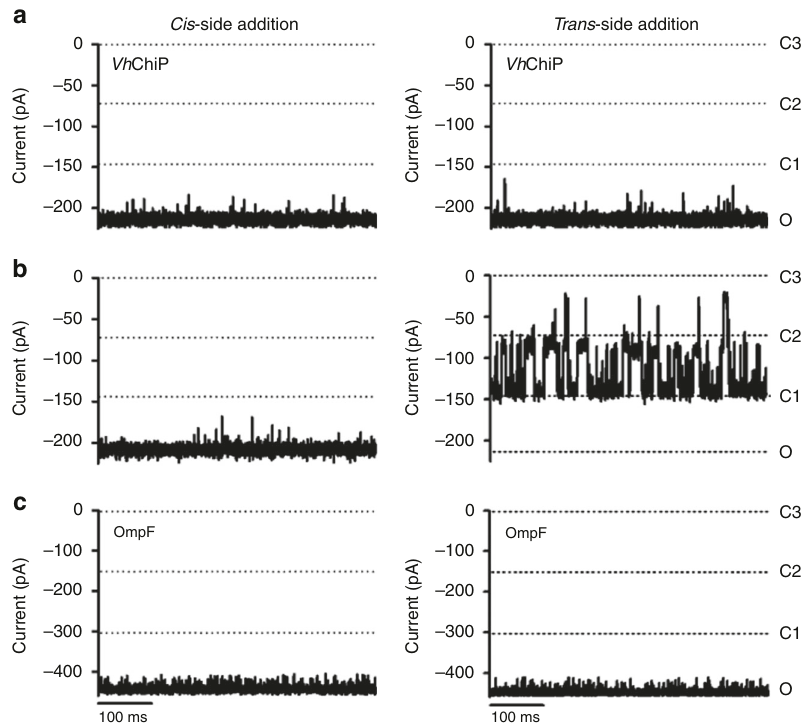
Fig. 8 Channel blockage by an N-terminal plug peptide. Single-channel current traces at − 100 mV (1 M KCl) of truncated VhChiP in the absence ( a ) and presence of 100 μ M ( b ) of the plug peptide DGANSDAAK. c E. coli OmpF traces in the presence of 200 μ M peptide. Traces shown are representative